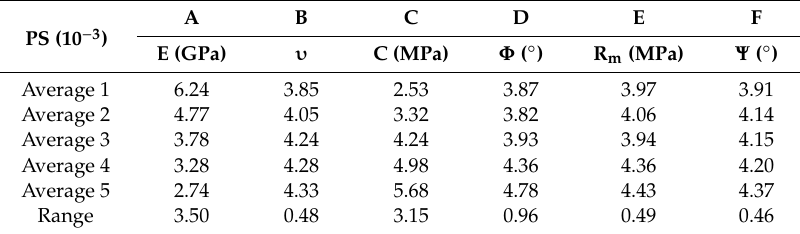
Table 6. Statistics describing the influence of mechanical parameters on PS.